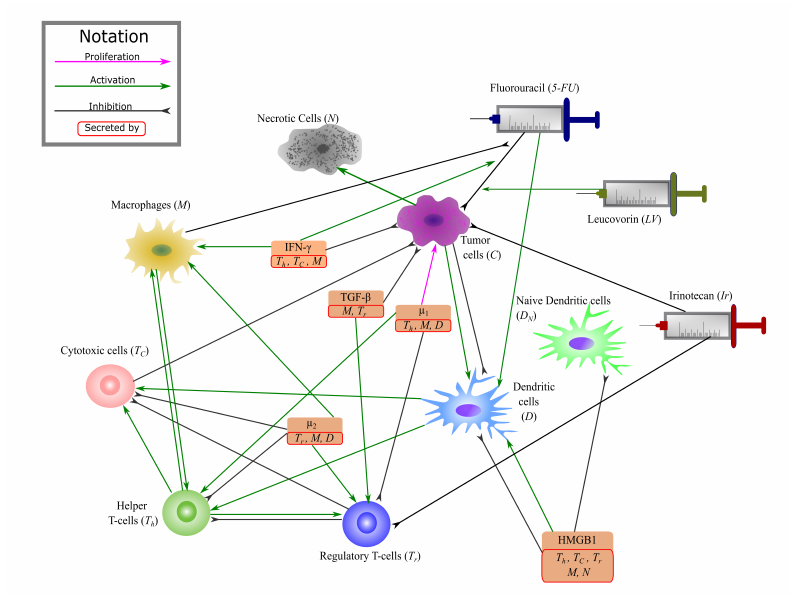
Figure 1. Interaction network of FOLFIRI drugs. Interaction network among the key players in tumor microenvironment and FOLFIRI